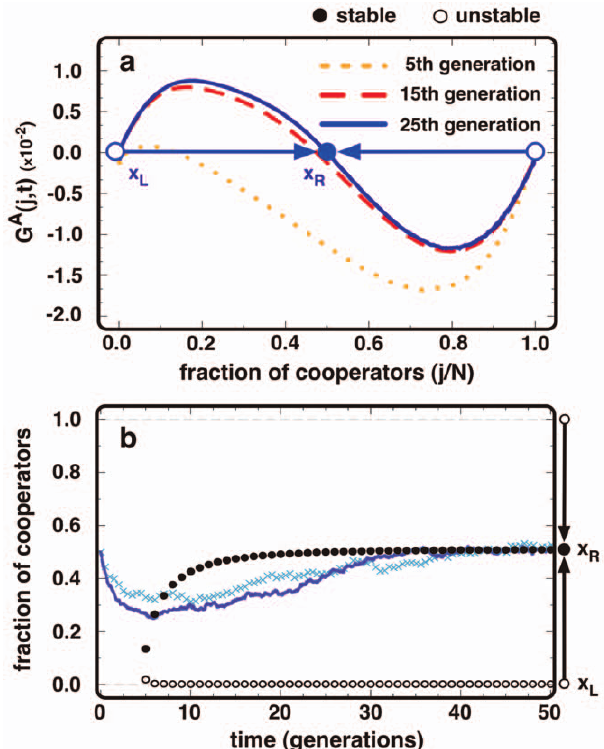
Figure 2. Time-dependent AGoS. ( a ) We plot G A (j,t) for three different instants of evolutionary time. Each line provides a snapshot for a given moment, portraying the emergence of a population-wide (time- dependent) co-existence-like dilemma stemming from an individual (time-independent) defection dominant dilemma ( PD ). ( b ) The circles show the position of the different interior roots of G A (j,t) , whereas the solid (dark blue) line and (light blue) crosses show two independent evolutionary runs starting from 50% of C s and D s randomly placed in the networked population. Open (full) circles stand for unstable, x L (stable, x R ) roots of G A (j,t) ( B =1.01 , N =10 3 , , k . =4 and b =10.0 ).